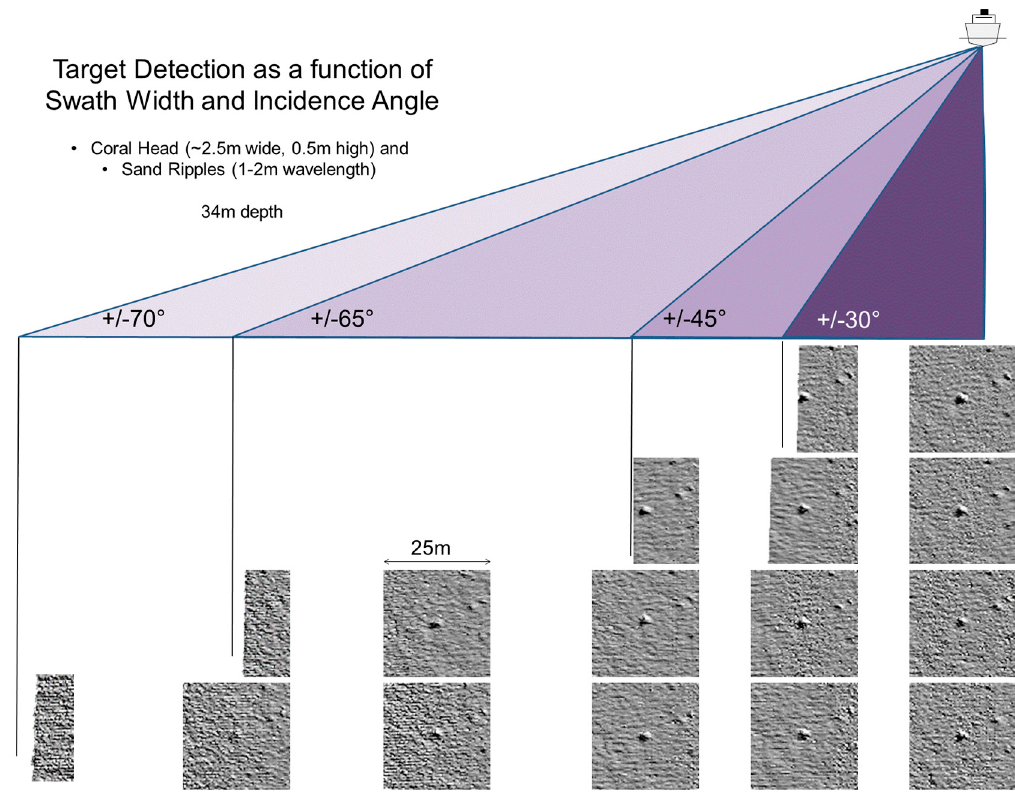
Figure 11. Impact of sector width choice on achievable resolution. A singular coral head in ~34 m of water, lying within a field of sand ripples, is viewed using the same sonar system (EM710 0.5° × 1.0°) using a range of elevation angles and swath widths. Each subarea view is a 25 m square gridded at 0.25 m resolution which is centered on the known position of the coral head. Each view is at a specific incidence angle (right to left: nadir, 30, 45, 60, 65 and 70 degrees) and with a specific sector width (top to bottom: ±30, 45, 65 and 70 degrees).